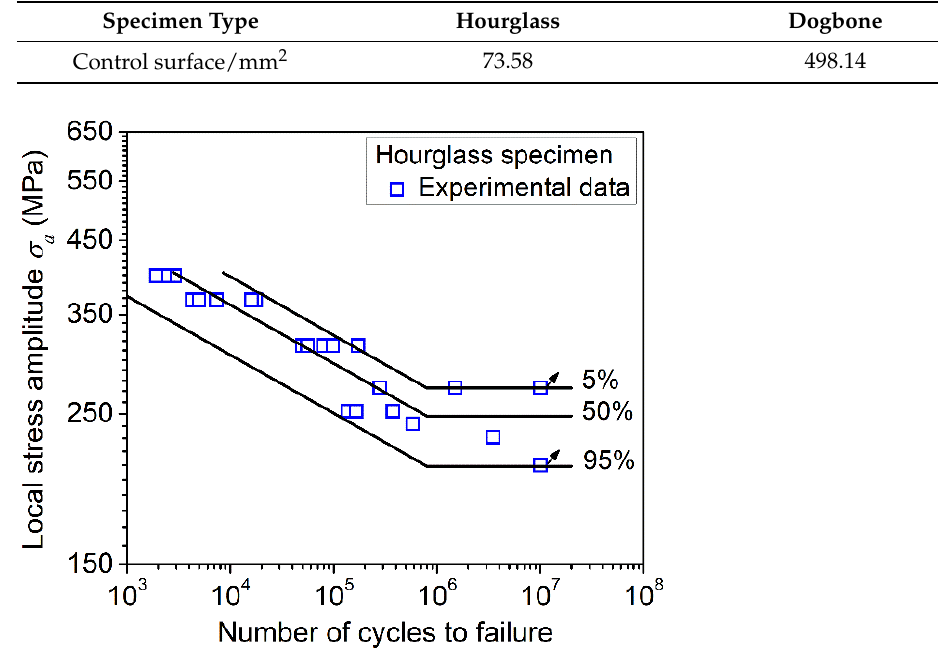
Table 2. Control surface of specimens with different size and shape.